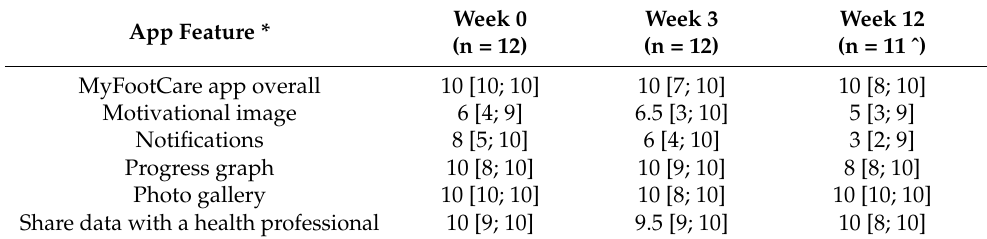
Table 2. Participant ratings of MyFootCare app usefulness, reported as median